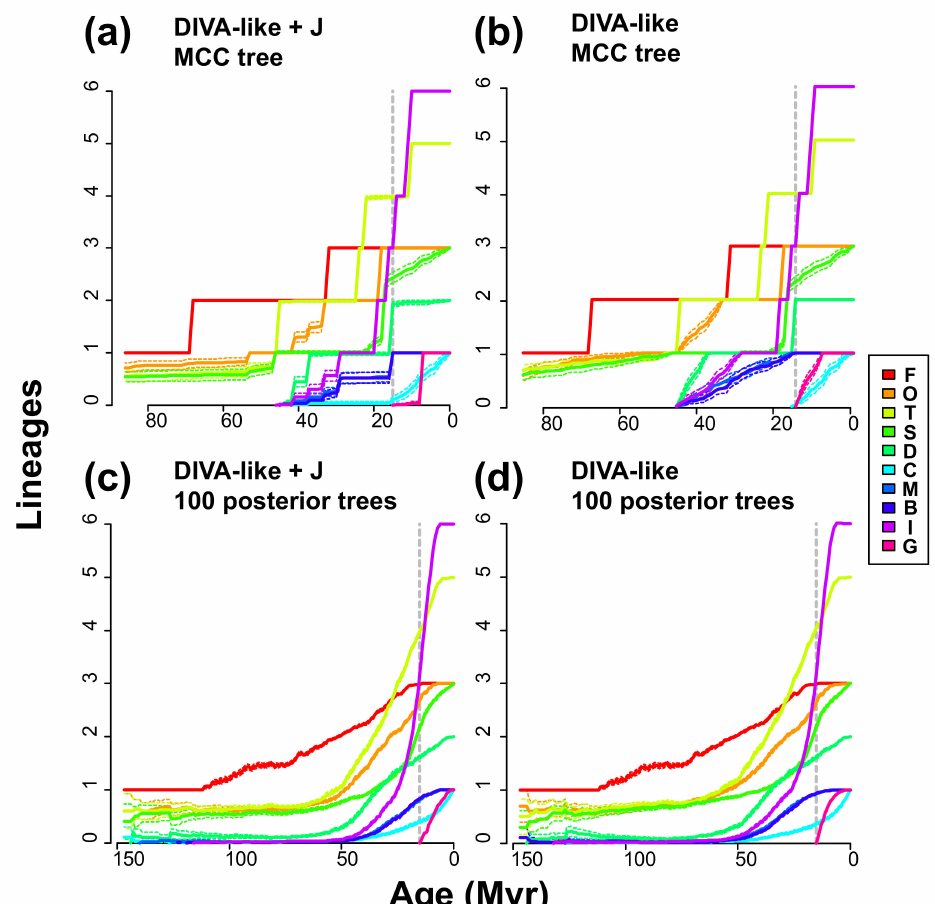
Figure 3. Number of lineages occupying each area through time. Solid lines are the average of 100 biogeographic stochastic maps, and dashed lines are the 95% confidence interval. See Figure 2 for area abbreviations. The dashed vertical line indicates the boundary between time slices in the time-stratified analysis. Runs on a single maximum clade credibility tree ( a , b ) show abrupt changes in the number of lineages that are related to cladogenetic events, whose age does not vary because there is no uncertainty associated to the tree. This effect is more pronounced in the model with founder-event speciation ( a ) because it relies more on cladogenetic events for estimating ancestral ranges. Using several trees (each with 100 stochastic maps) to account for topological and age uncertainty removes this effect and smooths the curves ( c , d ), reducing differences between models with and without founder-event